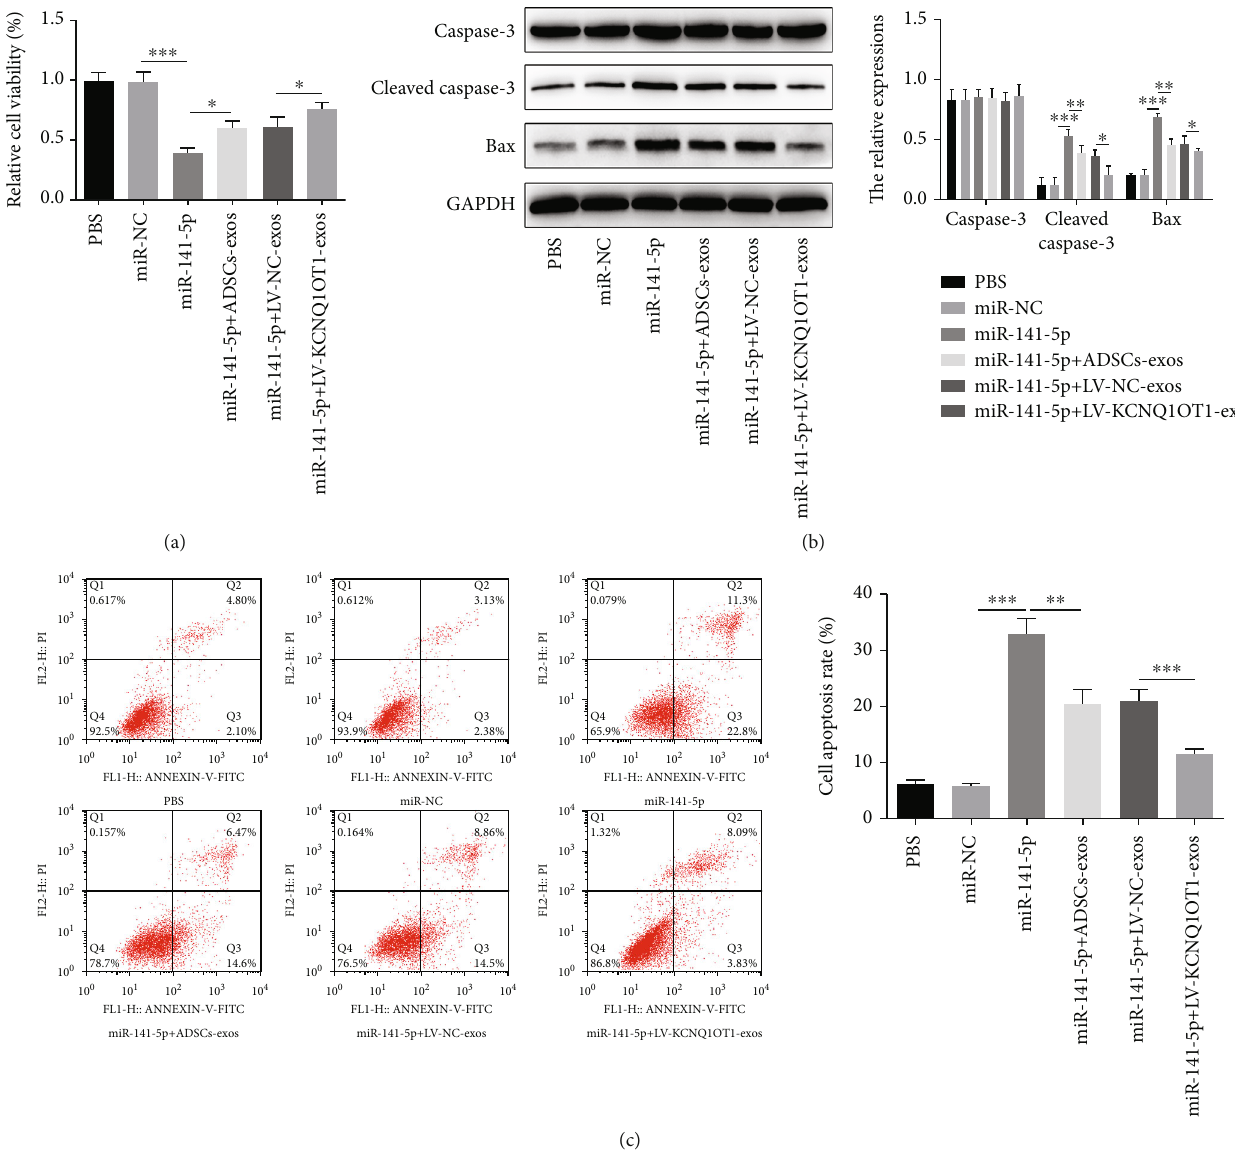
Figure 7: KCNQ1OT1-Exos inhibit the e ff ect of TNF- α in primary osteoblasts by sponging miR-141-5p. (a) Primary osteoblasts were treated with TNF- α and then treated with miR-NC, miR-141-5p, miR-141-5p+ADSCs-Exos, miR-141-5p+LV-NC-Exos, or miR-141- 5p+LV-KCNQ1OT1-Exos, respectively. (b) The inhibitory e ff ect of TNF- α on cell viability was blocked by miR-141-5p, and the treatment of ADSCs-Exos or LV-KCNQ1OT1-Exos partly reversed this phenomenon; ADSCs-Exos exerted a weaker stimulative e ff ect on cell viability compared to LV-KCNQ1OT1-Exos; the expression of cleaved caspase-3 and Bax was enhanced by miR-141-5p but was attenuated following coculture with ADSC-Exos or LV-KCNQ1OT1-Exos. (c) As fl ow cytometry showed, miR-141-5p promoted cell apoptosis while the treatment of ADSC-Exos or LV-KCNQ1OT1-Exos inhibited that; ADSCs-Exos exerted a weaker inhibitory e ff ect on cell apoptosis compared to LV-KCNQ1OT1-Exos. ∗ P < 0 : 05 , ∗∗ P < 0 : 01 , and ∗∗∗ P < 0 : 001